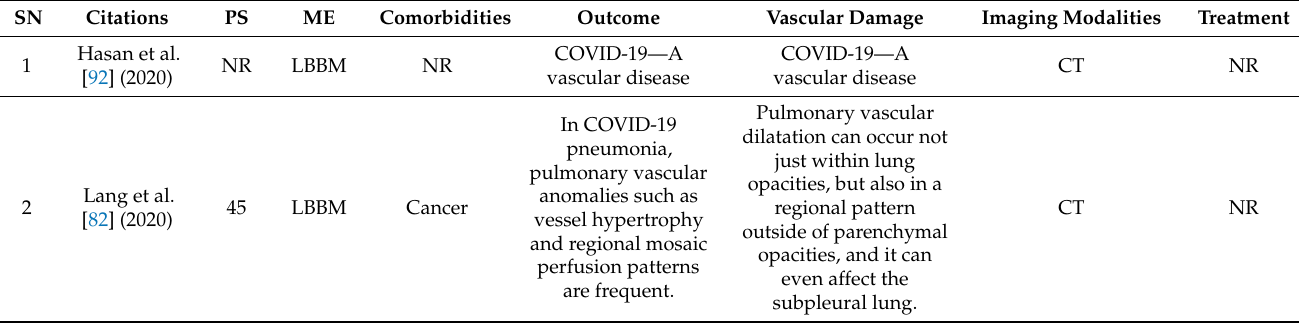
Table 1. The effect of COVID-19 on